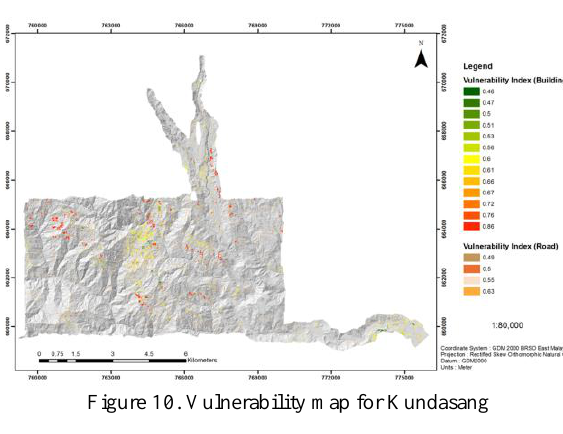
Figure 9. Vulnerability map for Kota Kinabalu